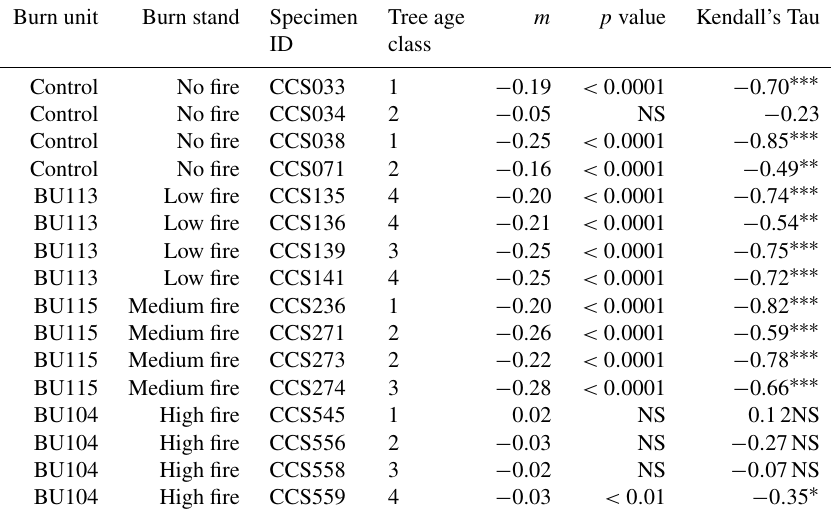
Table 2. Estimated slope coefficient based on linear regression ( m ), p value based on linear regression, and Kendall’s Tau based on the Mann–Kendall test (MK test). The MK test looks for evidence of a monotonic trend in a time series and is robust to non-normally distributed data. In the Kendall’s Tau column, the ∗ symbols indicate the following: ∗ p < 0 . 05, ∗∗ p < 0 . 01, and ∗∗∗ p < 0 . 0001. NS stands for not significant. Trees in age class 1 contain < 129 rings, trees in age class 2 contain 130–159 rings, trees in age class 3 contain 160–189 rings, and trees in age class 4 contain > 190